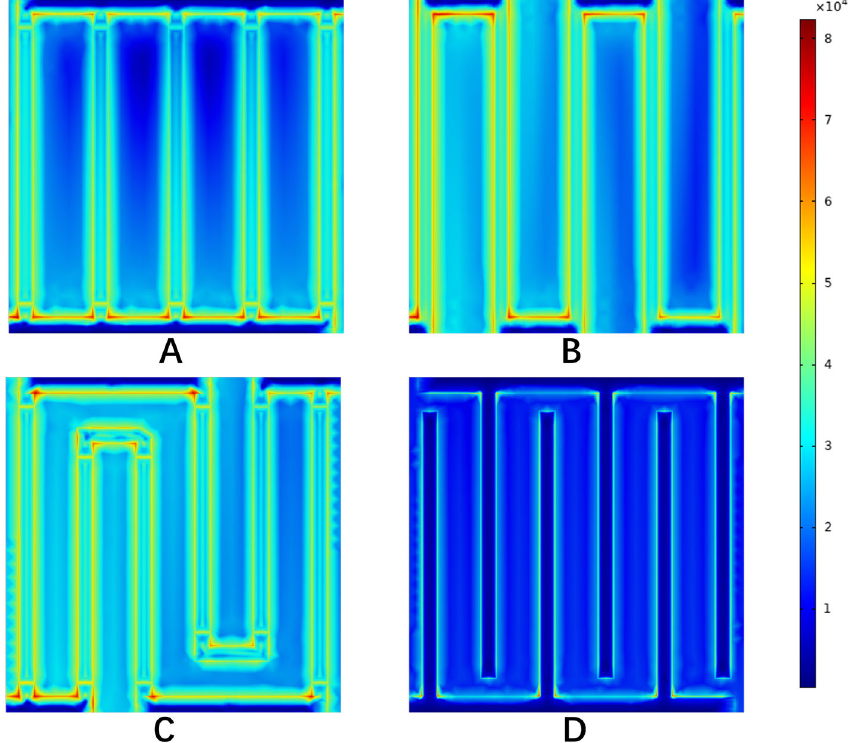
Figure 11. The current density distribution on anode electrode under different flow fields. ( A ) Parallel, ( B ) serpentine, ( C ) multi-serpentine, ( D ) interdigitate.